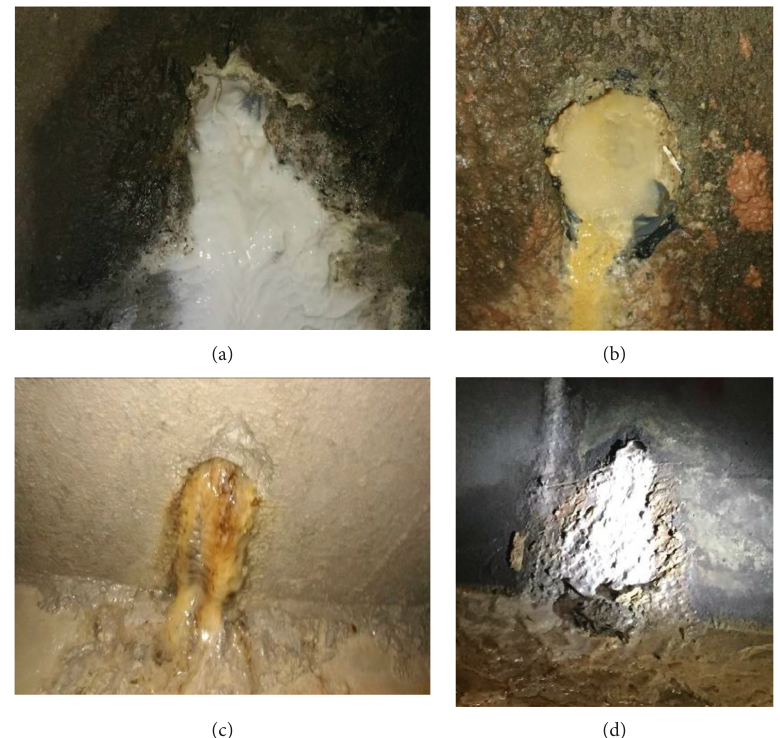
Figure 1: Tunnel drainage pipes that are blocked by crystal. (a) Tunnel between Chongqing North Railway Station and Yulu Station. (b) Tunnel between Danzishi Station and Tushan Station. (c) New Zhongliang Mountain tunnel. (d) Tongluo Mountain